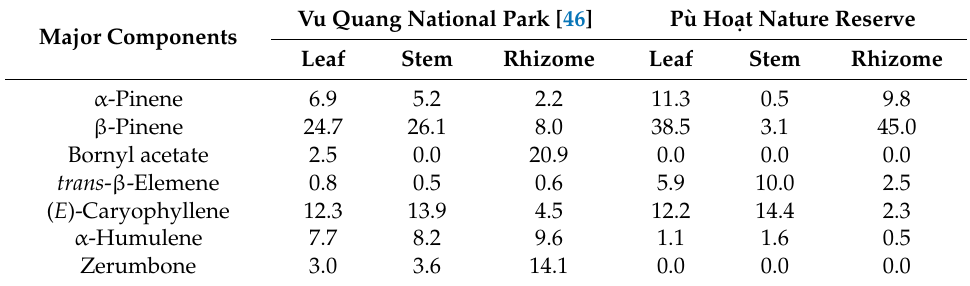
Table 4. Major components in the leaf, stem, and rhizome essential oils of Zingiber vuquangensis . Major